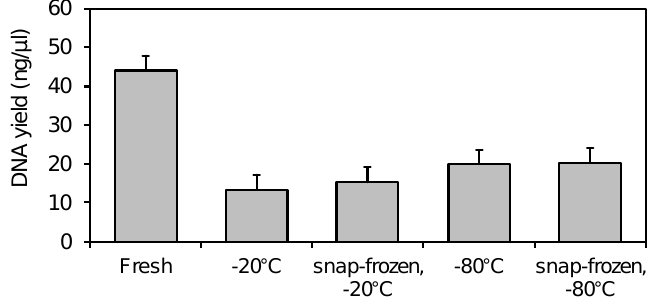
Figure 1. Least square means of DNA extraction yields (ng/µL) from 250 mg fresh fecal samples and freeze-stored fecal samples (−20 °C and −80 °C with or without prior snap-freezing in liquid nitrogen). Polynominal contrasts: DNA extraction from fresh vs. frozen feces; p < 0.001; storage at −20 °C vs. −80 °C, p = 0.143; snap-freezing vs. none prior to freeze-storage, p = 0.761. Bars represent standard error of the mean, n = 6.